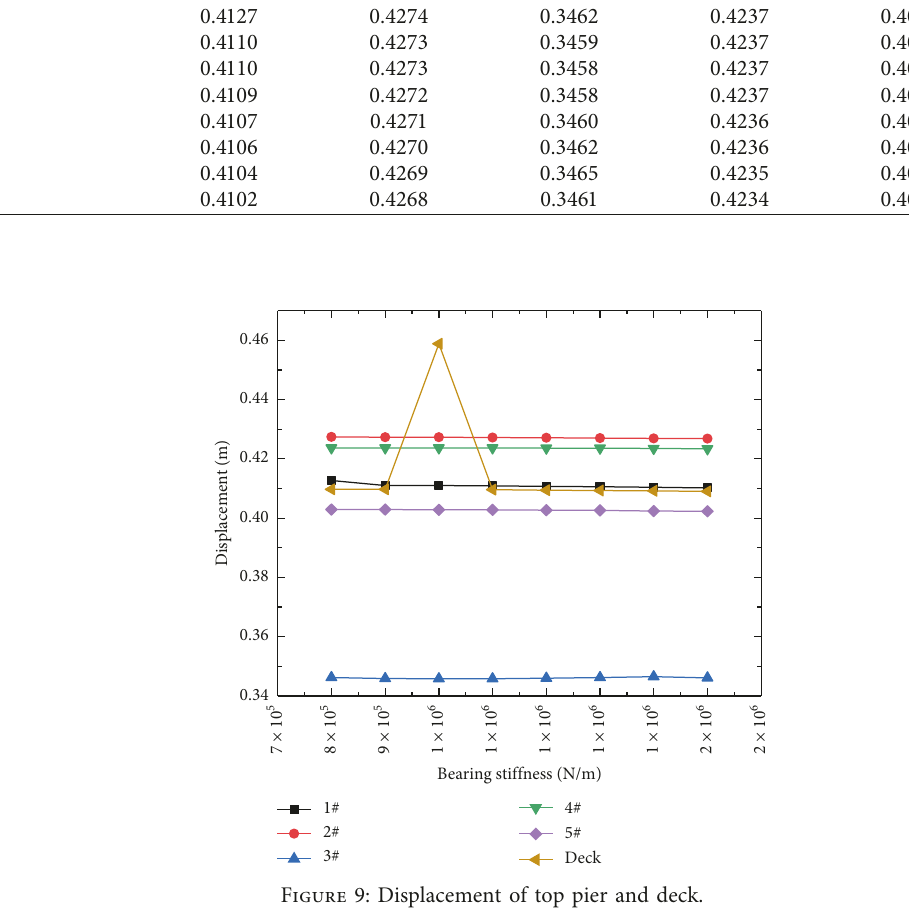
Table 5: Shearing force of pier bottom (N).